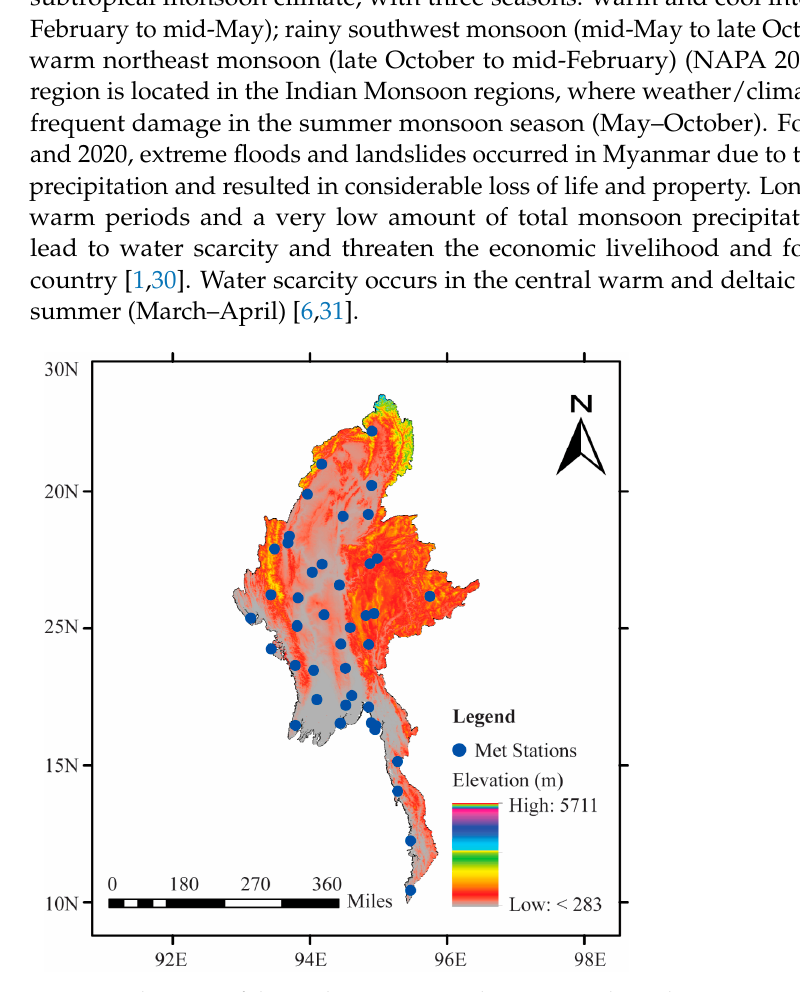
Figure 1. Elevation of the study area map with 42 meteorological stations across Myanmar.